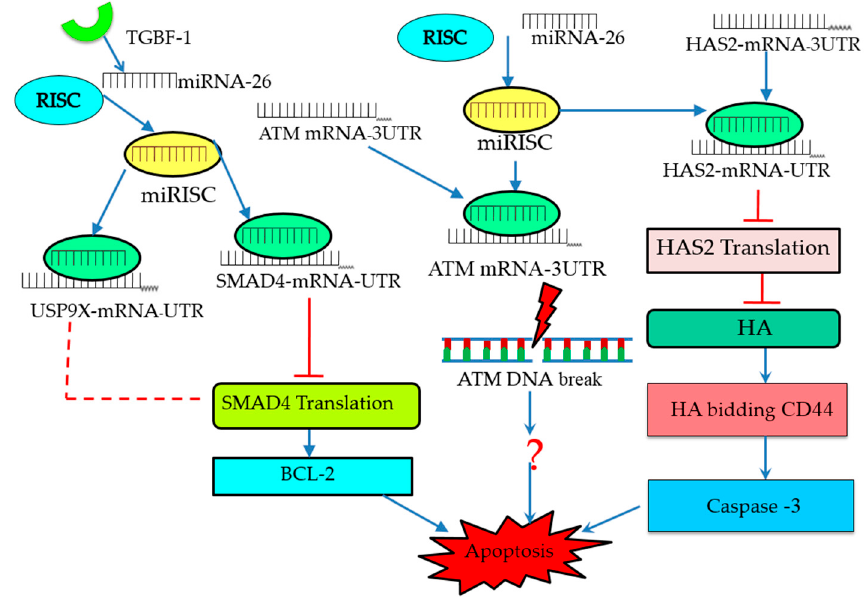
Figure 2. Model of miR-26b–mediated pathways in the regulation of follicular GC (granulosa cell) apoptosis. miR-26b promotes GC apoptosis by activation of BCL2, DNA breaks and caspase-3 through its target genes (SMAD4, ATM and HAS2). miRISC form complex with SMAD4-mRNA and directly block it’s translation, while USP9X form the complex and indirectly inhibit the ubiquitination of SMAD4 and cause apoptosis by activating BCL-2. HAS2-mRNA and miRISC form complex and inhibit the synthesis of HA and cause apoptosis through activating downstream factor, Caspase-3. miRISC, miRNA-induced silencing complex; B-cell lymphoma 2 family, BCL2; SMAD4, Sma and Mad-related protein 4; ATM, ataxia telangiectasia mutated; HA, hyaluronic acid; HAS2, hyaluronan synthase 2; USP9X, ubiquitin specific peptidase 9, X-linked.